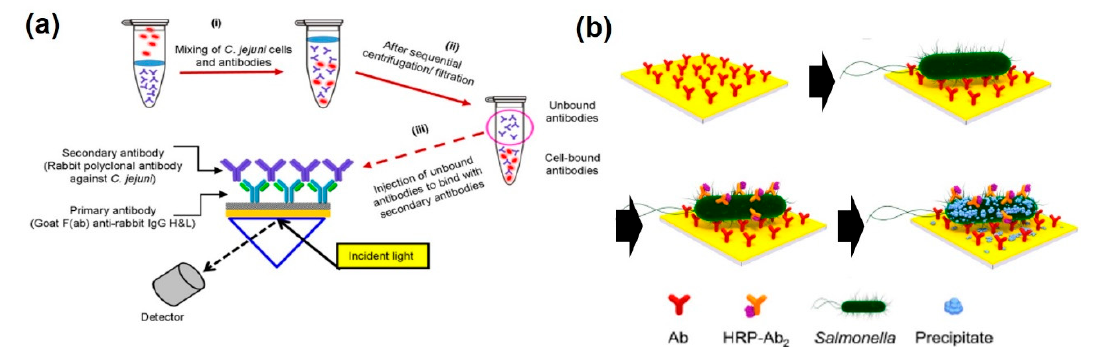
Figure 5. PSPR-based immunosensors for pathogenic microbe detection. ( a ) The specificity of developed C. jejuni assay using unbounded secondary antibody detection; ( b ) SPR chip with the immobilized capture antibody, binding of Salmonella, HRP-Ab conjugate, and HRP-catalyzed conversion of 4-chloro-1-naphthol to insoluble benzo-4-chlorocyclohexadienone. ( a ) Figure reproduced with permission from [68], © 2019 Springer Nature; ( b ) Figure reproduced with permission from [69], © 2016 American Chemical